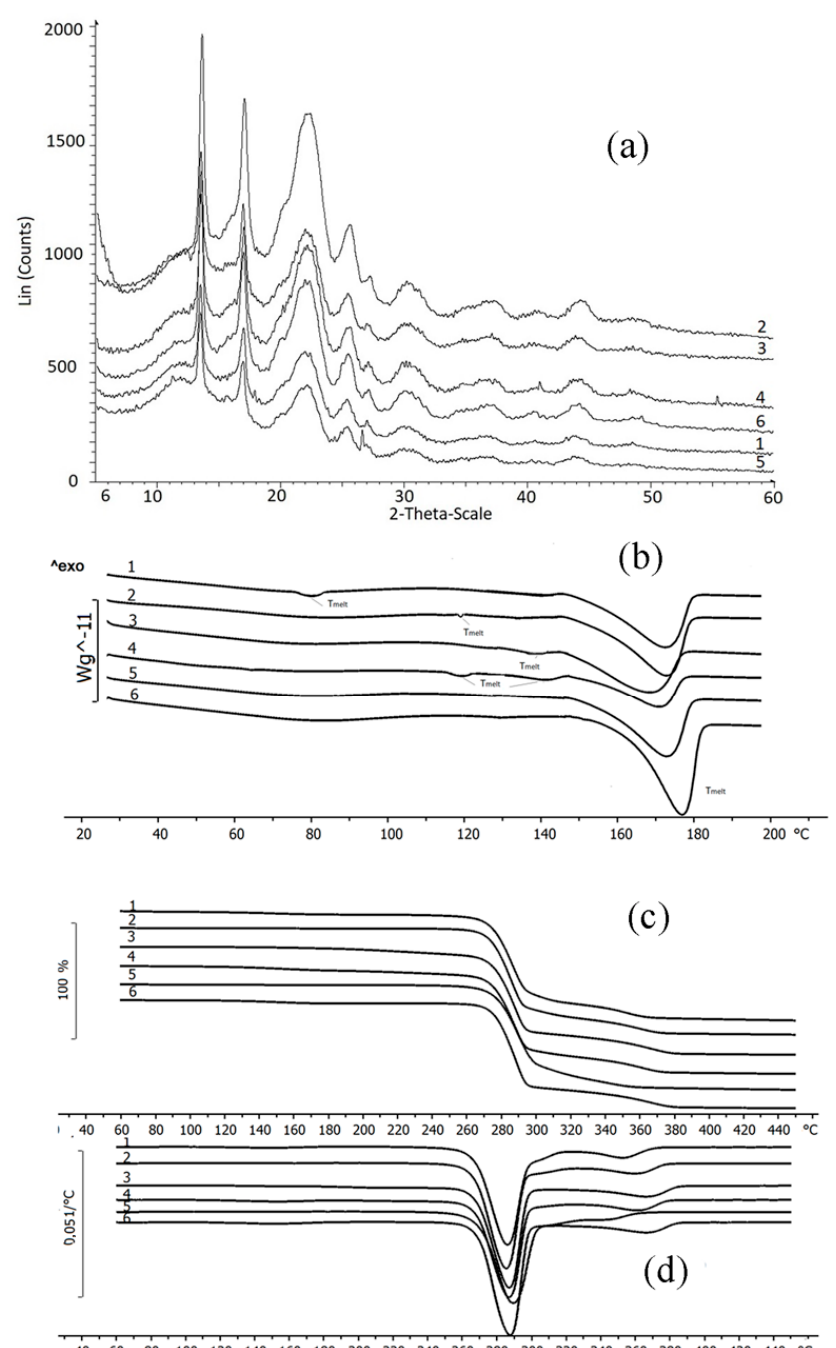
Figure 6. X-ray images ( a ), DSC curves ( b ), DTA curves ( c ) and weight loss of the fungicide loaded granules in the differential form ( d ): 1—P(3HB)/wood flour/difenoconazole; 2—P(3HB)/wood flour/azoxystrobin; 3—P(3HB)/wood flour/mefenoxam; 4—P(3HB)/wood flour/azoxystrobin + mefenoxam; 5—P(3HB)/wood flour/prothioconazole; 6—P(3HB)/wood flour. TGA curves had two degradation regions for each sample because the ranges of degradation temperatures of the components overlapped. P(3HB) lost 98% of its mass at temperatures between 275 ◦ C and 293 ◦ C; wood flour was degraded at a wide temperature range, between 250 ◦ C and 500 ◦ C; fungicide degradation temperatures varied between 236 ◦ C (prothioconazole) and 329 ◦ C (difenoconazole). Each sample lost 68–70% of its mass at temperatures between 273 ◦ C and 293 ◦ C, which corresponded to the